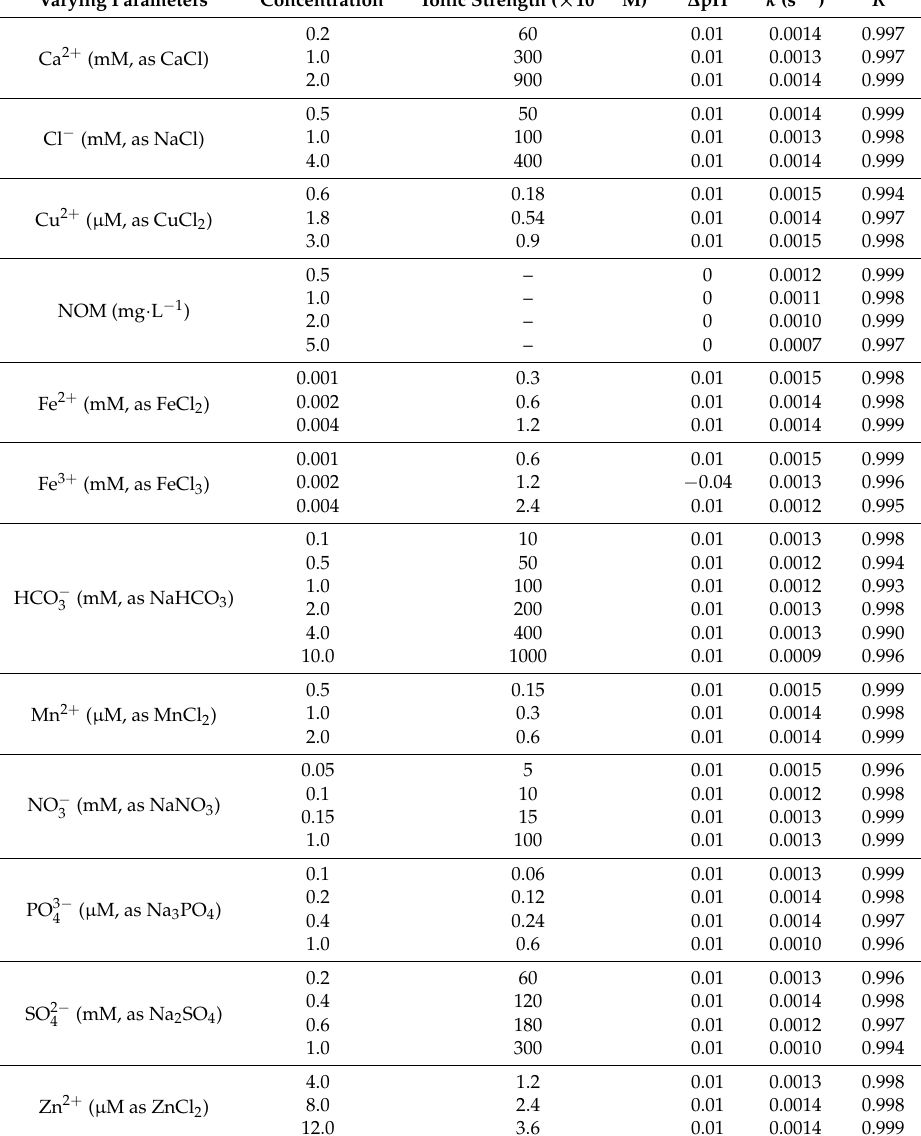
Table 2. Pseudo-first-order rate constants for AHTN degradation by UV/FC under various conditions.